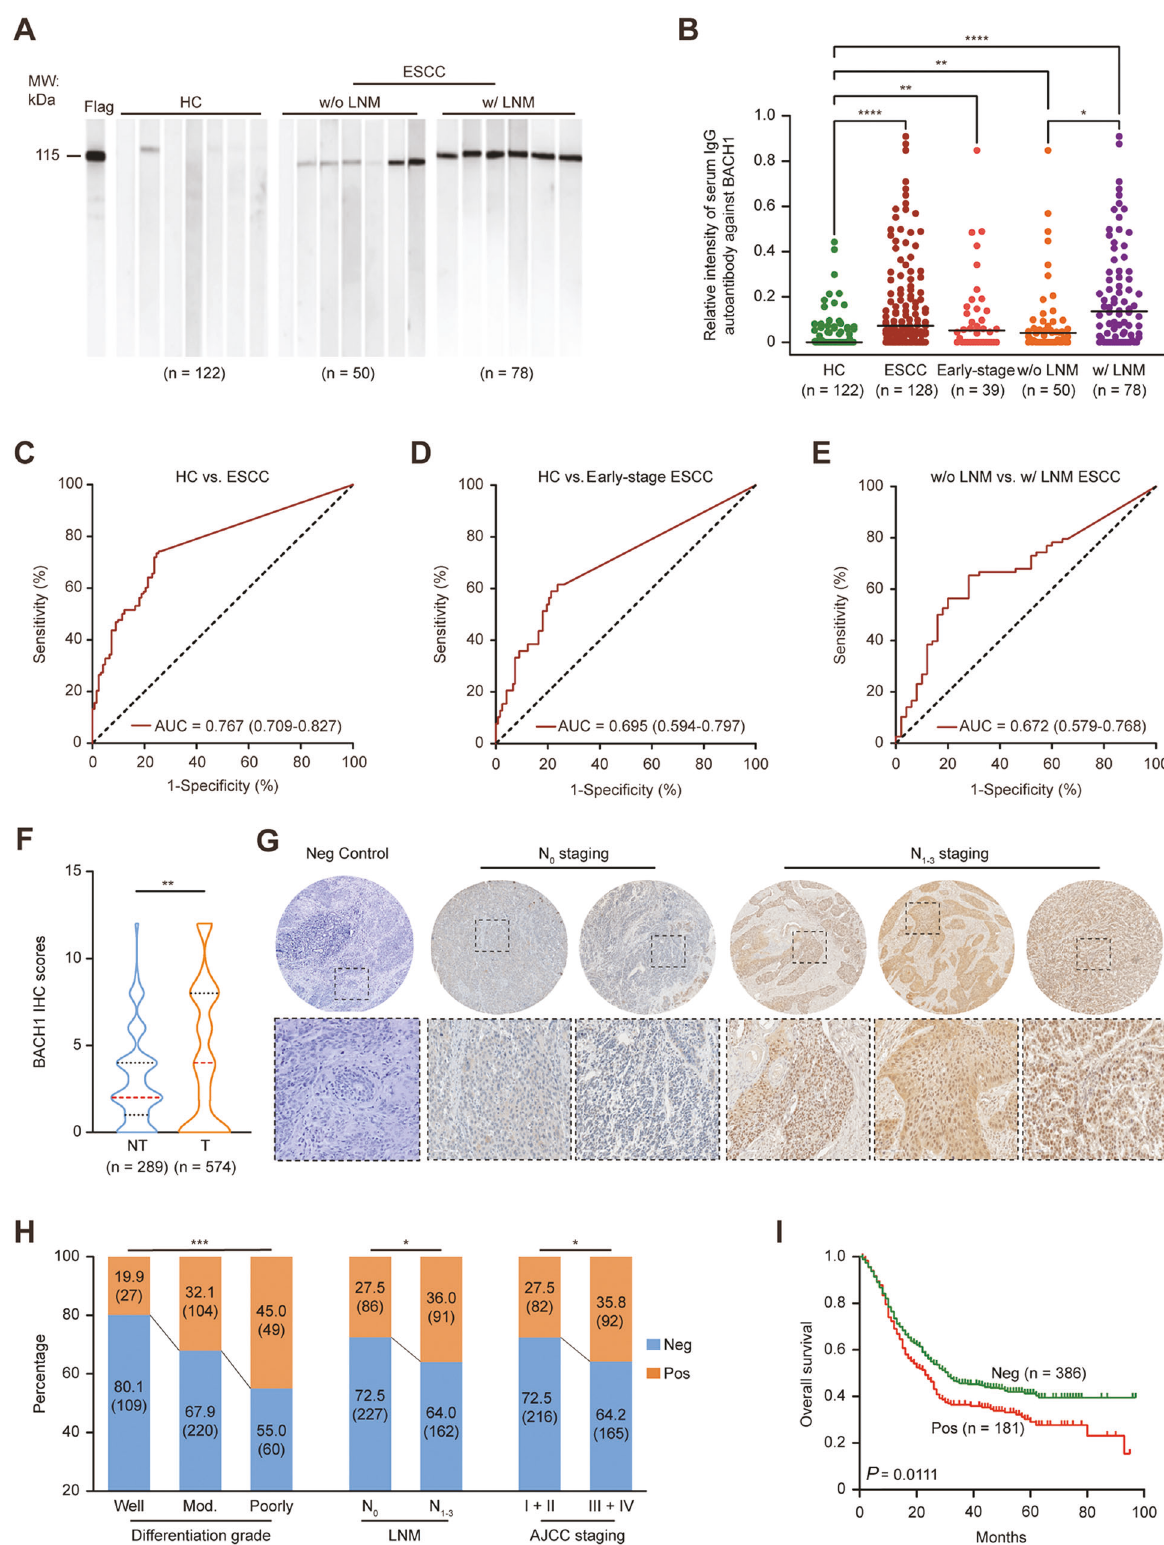
Regarding the anti-BACH1 test, both the sensitivity and speci fi city reached 100% in the discovery cohort (Fig. 1E; Supplementary Table S7). The fl uorescence intensity was extremely low in healthy individuals and weak in ESCC patients without lymph node Cell Death and Disease (2023)